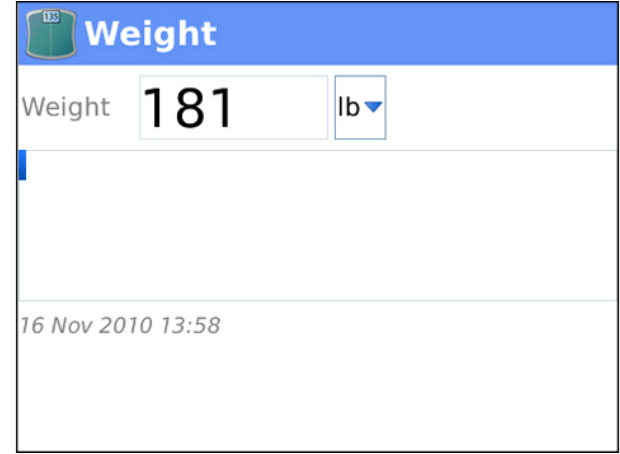
Figure 7. Weight Tracker: Clients enter weight and enter comments on the reading.